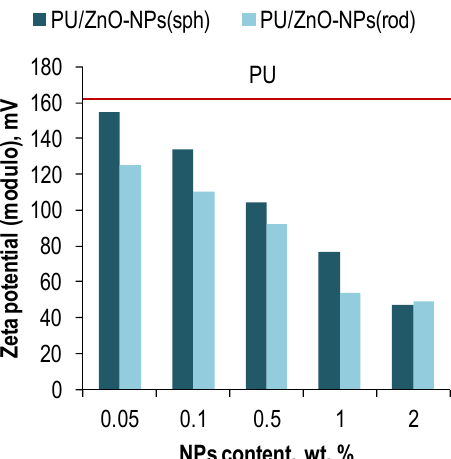
Figure 3. The zeta potential of the polymer solutions based on PU/ZnO-NPs in THF.